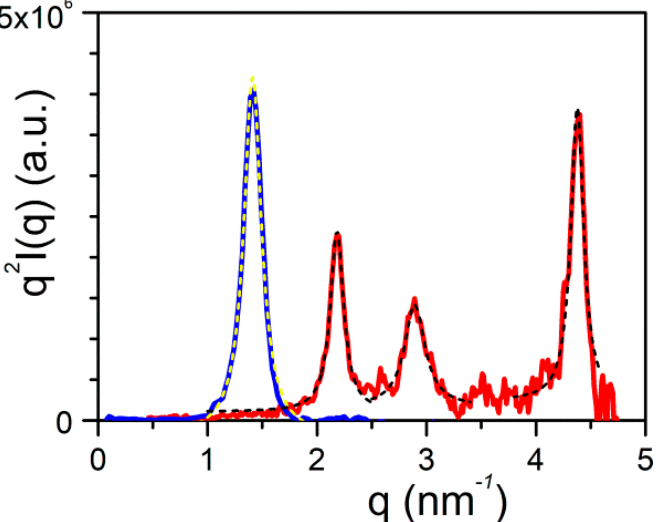
Figure 10. SAXS scattering: blue line is the diffraction patterns for OPVOH (Appendix A Figure A1b), and red line for OPVR (Appendix A Figure A1a) gels in benzyl alcohol [13]. Dashed lines stand for the fits of the different peaks with Equation (16).